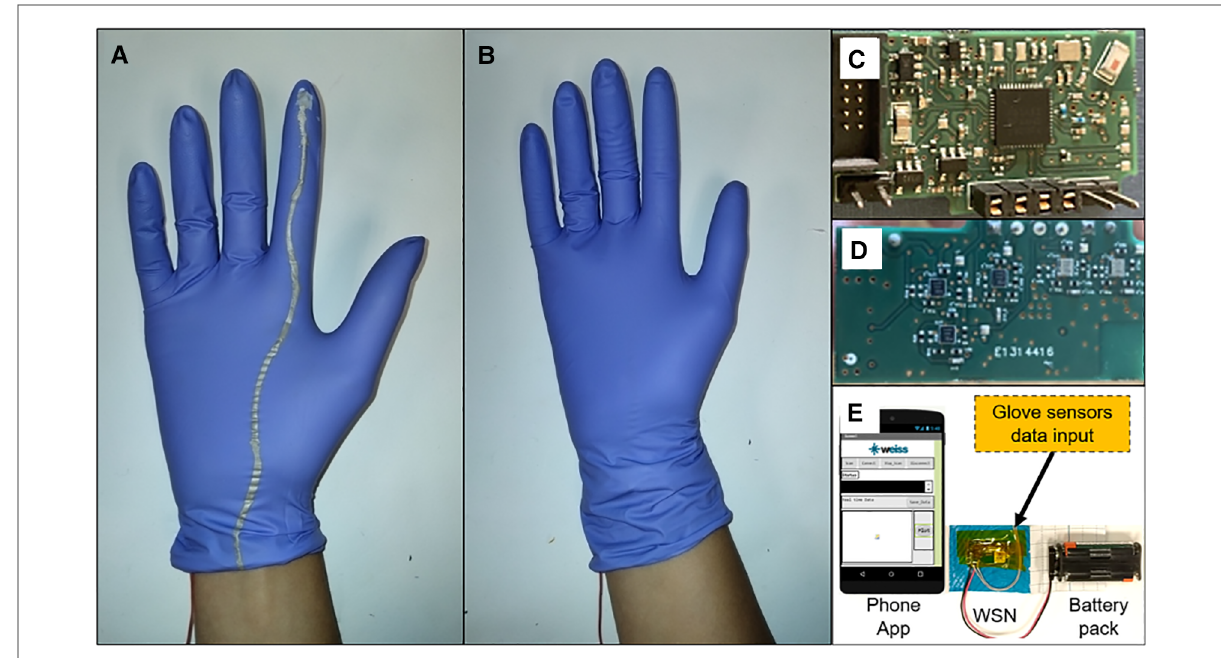
FIGURE 1 Sensorised device for digital vaginal examination. ( A ) Photograph of sensorised glove with sensor on the fi ngertip and fl exible interconnect printed on the glove. ( B ) Photograph of sensorised glove covered by a sterile surgical glove for sterility purposes. ( C ) Photograph of customized wireless sensor node (front). ( D ) Photograph of customized wireless sensor node (back). ( E ) Designed wireless system for real-time data